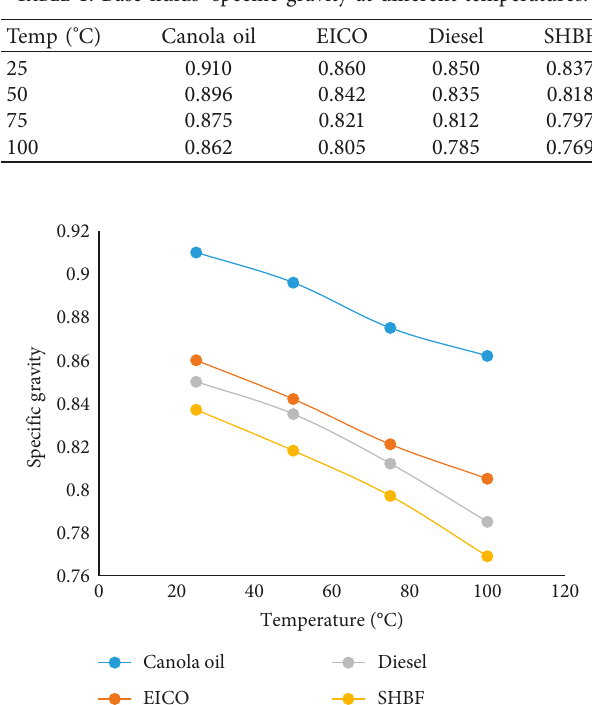
Table 1: Base fluids’ specific gravity at different temperatures.